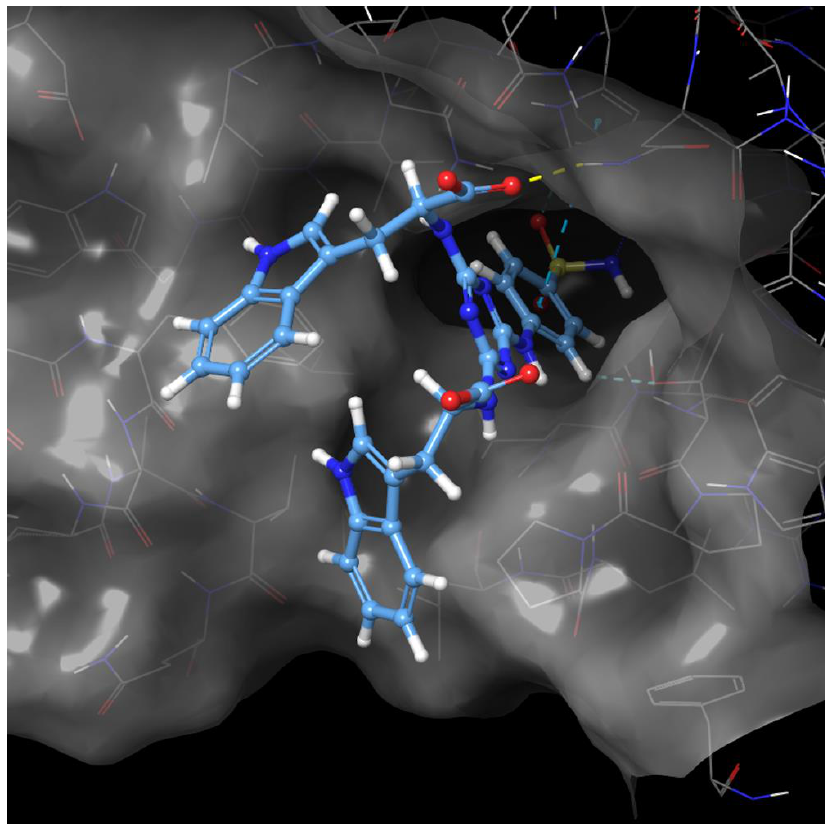
Figure 1. Molecular surface of the binding site of hCA II with docked compound 6 (Trp derivative).